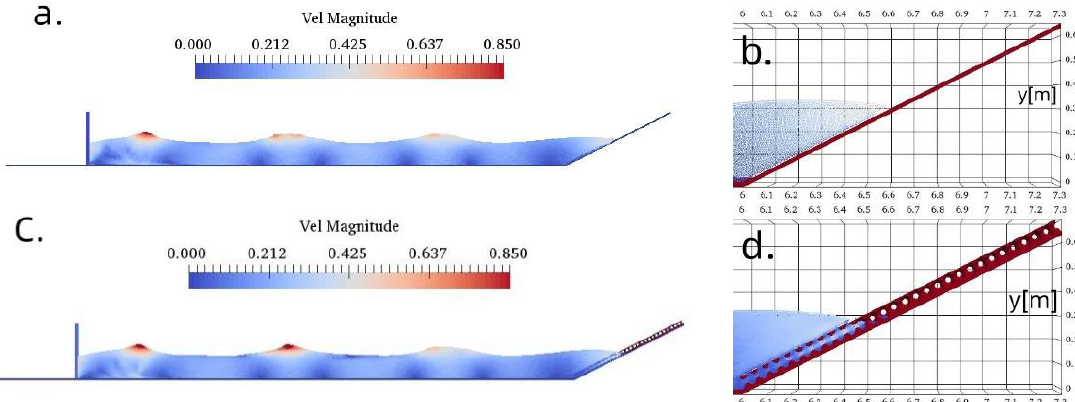
Figure 7. Wave patterns and velocity distribution at t = 5.25 s when thewave propagates to the breakwater: ( a ) Without article block; ( b ) Zoom in; ( c ) With article block; ( d ) Zoom in.